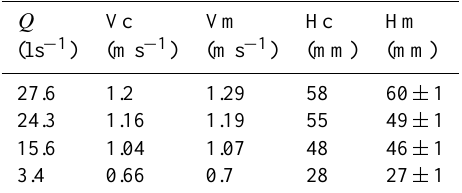
Table 1. Comparison of calculated (subscript c) and measured (sub- script m) flow velocity and flow depth in the physical scale model for different clear water discharges Q half-way between inlet and outlet of the modelled